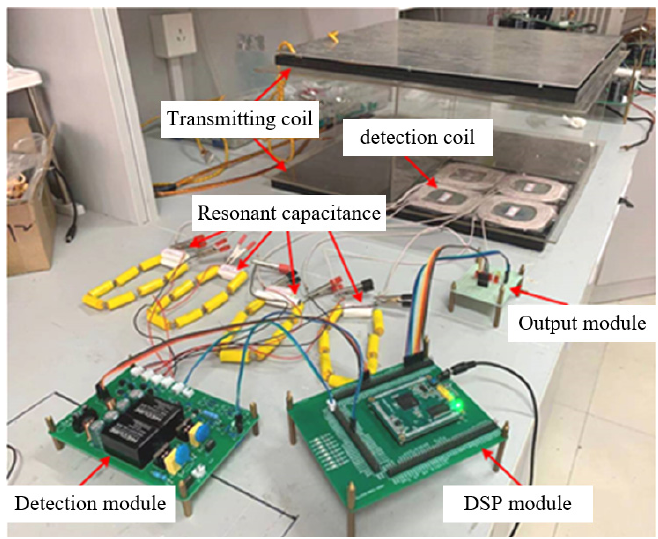
Figure 9. MOD experimental platform.